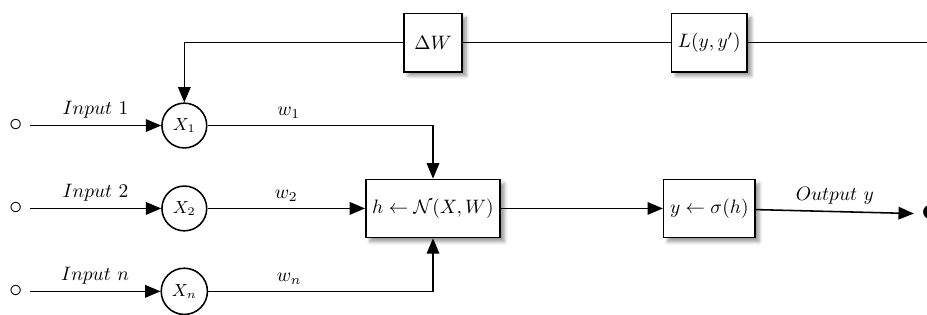
Figure 1. General neural layer